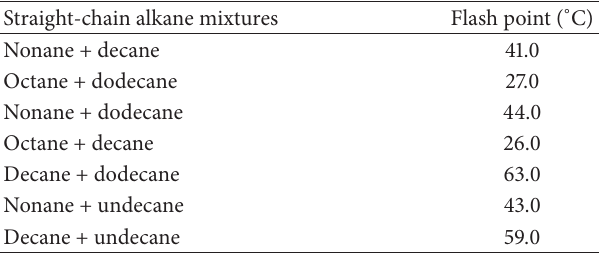
Table 3: Flash points of the straight-chain alkane mixtures using the volume ratio 1: 1.